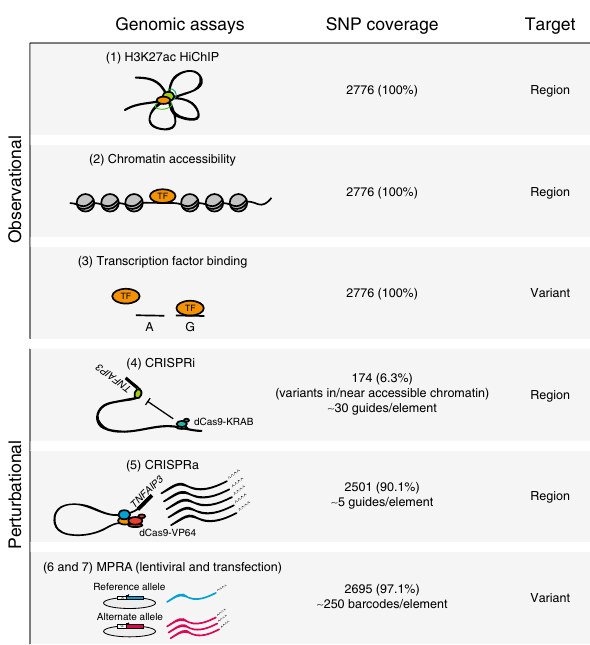
Fig. 2 Seven approaches for characterizing non-coding genetic variants. Genomic assays (left), the coverage of all common genetic variants in the 605 kb locus (middle), and whether the assay is speci fi c to genomic regions or variants (right), grouped into observational (top) and perturbational assays (bottom). (1) HiChIP can be used to identify active chromatin regions (H3K27ac labeled) that interact with the TNFAIP3 promoter. (2) DHS and ATAC-seq can be used to identify regions of accessible chromatin. (3) Variants predicted to alter TF binding can be identi fi ed using motif analysis in combination with evidence of TF binding by ChIP-seq 42 . Also see Supplementary Data 3 – 9. (4 and 5) Pooled CRISPRi and CRISPRa screens can determine regulatory potential of each region by repressing (CRISPRi) or arti fi cially inducing (CRISPRa) each targeted region. (6 and 7) MPRA (with lentiviral or transfection delivery strategies) can be used to test for allele-speci fi c reporter